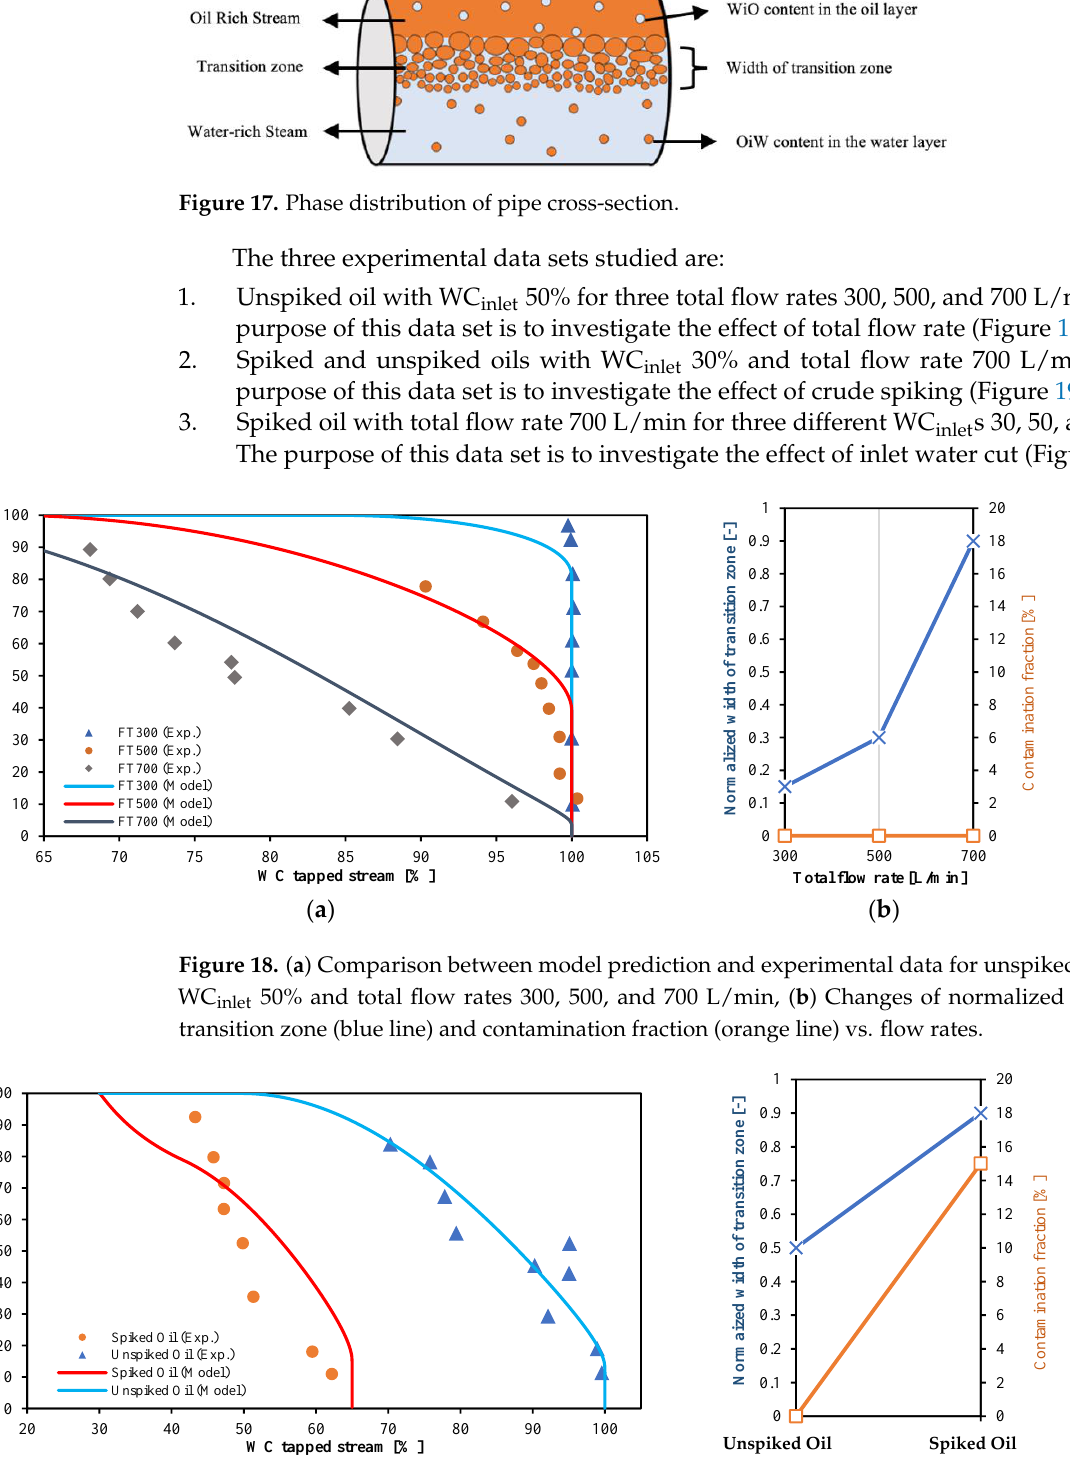
Spiked oil with total flow rate 700 L/min for three different WC inlet s 30, 50, and 70%. The purpose of this data set is to investigate the effect of inlet water cut (Figure 20).